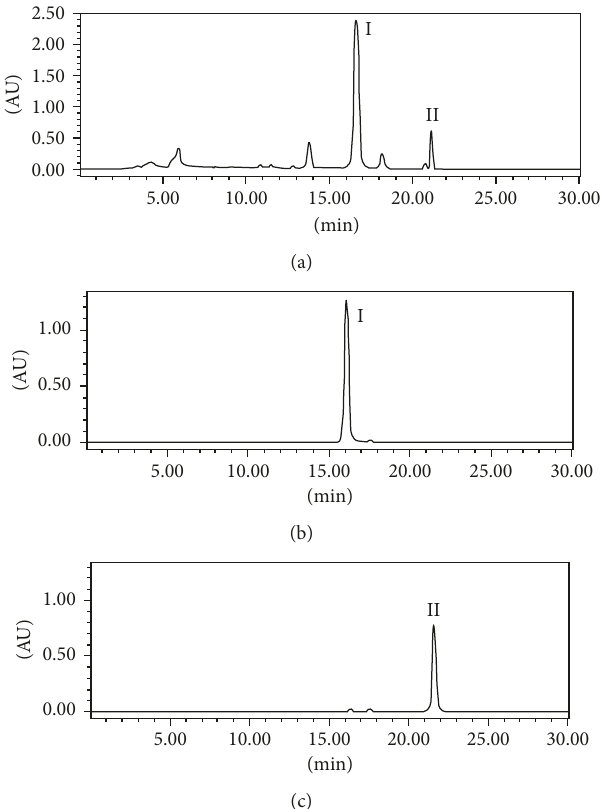
Figure 5: (a) HPLC chromatogram of the ethyl acetate extract from A. officinarum Hance; (b, c) HPLC analyses of target-separated antioxidants purified with HSCCC. Experimental conditions: column, Shim-pack VP-ODS column (250 × 4.6mm I.D., 5 μ m); column temperature, 25 ° C; mobile phase, 0.2% acetic acid-aceto- nitrile with the gradient (0–5 min, 55–68% B; 5–15 min, 68% B; 15–30min, 68–75% B); flow rate, 1.0mL/min; detection, 254nm; injection volume, 20 μ